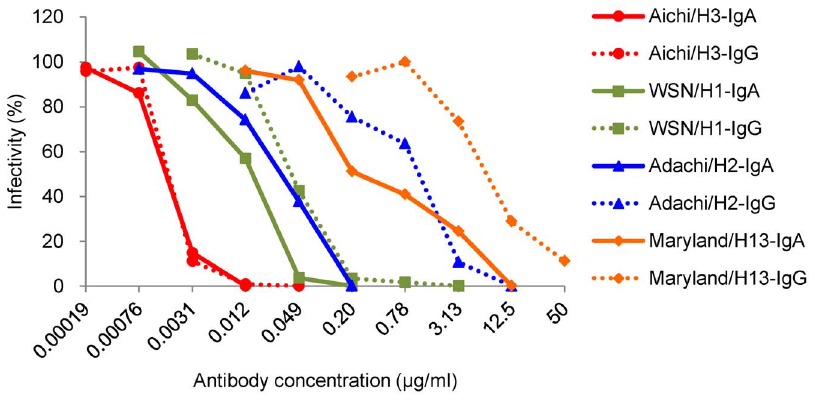
Figure 3. Comparison of neutralizing activities of S139/1 IgA and IgG antibodies. Appropriately diluted viruses were mixed with S139/1 IgA (continuous lines) or IgG (dashed lines) at the indicated dilutions. Neutralizing activities were evaluated by counting the number of plaques formed on MDCK cells. IC 50 values calculated based on the neutralization curves are shown in Table 3.